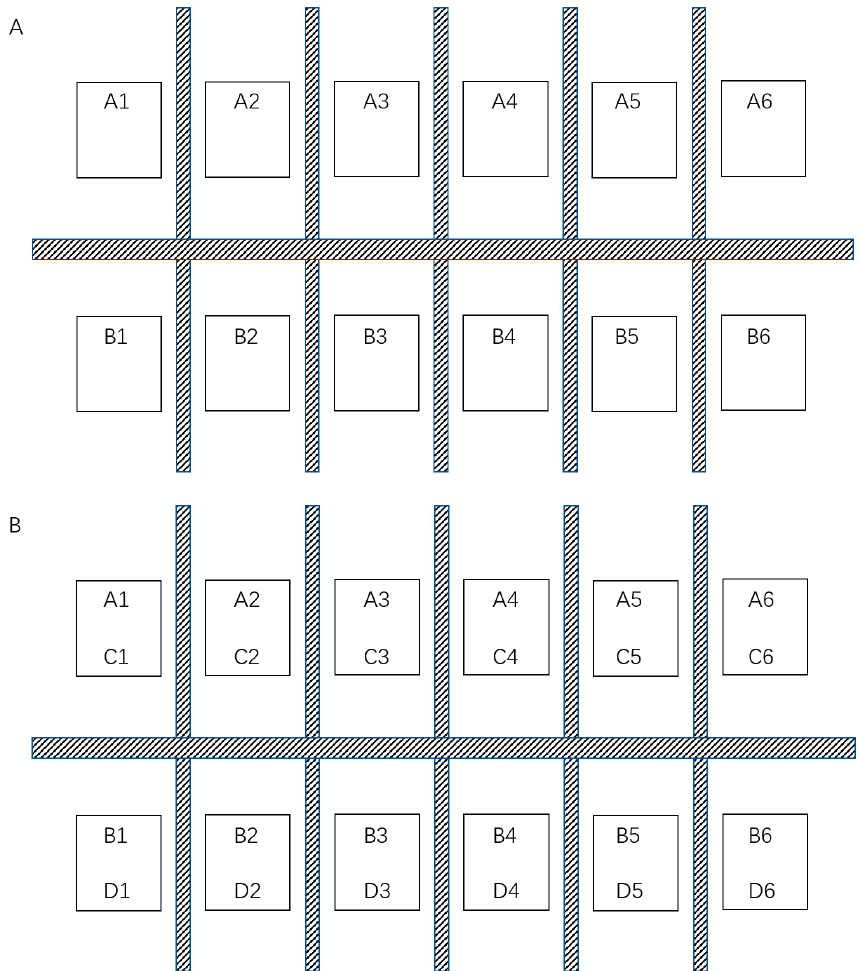
Figure 2. The design for in-vivo test distribution map. ( A ) The distribution of piglets in group A and group B. ( B ) The distribution of piglets in group A, group B, group C and group D. The combination of letters and numbers in the figure represents the piglet number in each group.